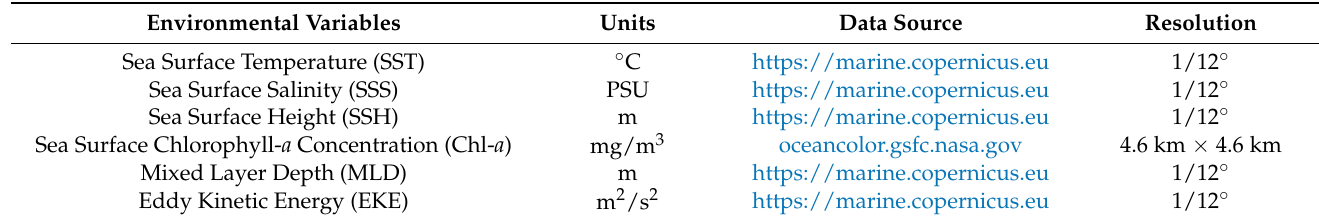
Table 1. Satellite-derived remotely sensed oceanographic environmental variables for the data sources and descriptions applied in the